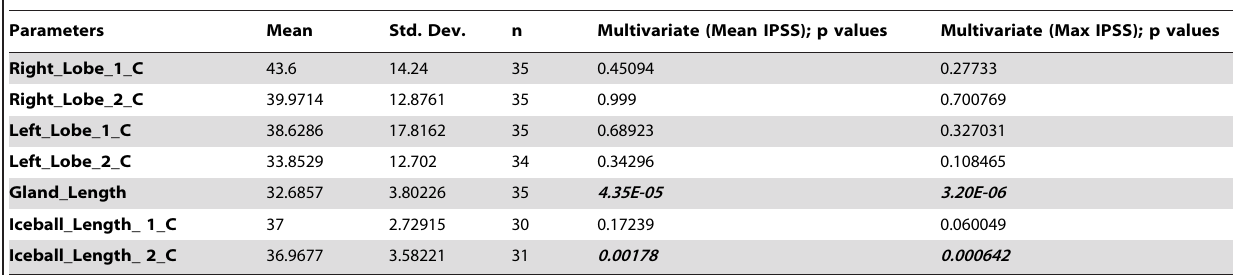
Table 3. Summary of multivariate analysis.